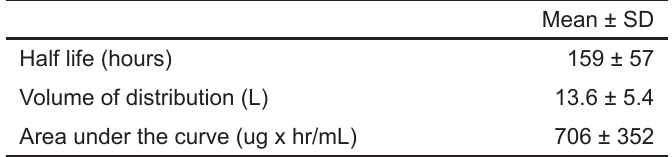
Table 6. Pharmacokinetics of Centruroides Immune F(ab’)